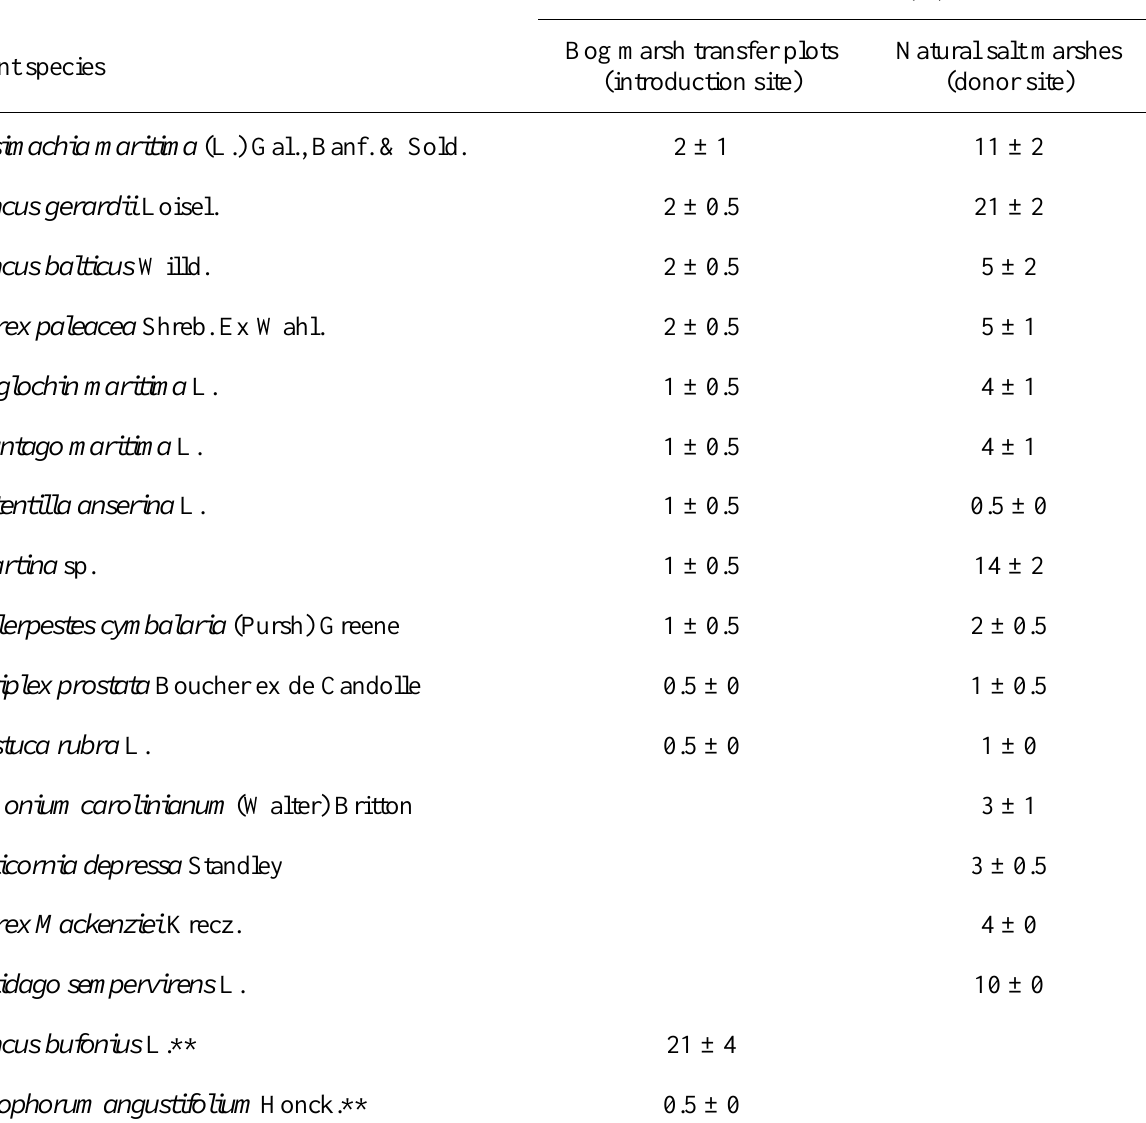
Table A1. Plant species diversity found in natural salt marshes one year after salt marsh diaspores were collected (15 species) was higher than in the experimental plots at the introduction site (11 species). Species are listed in descending order of cover in bog marsh transfer plots (mean ±